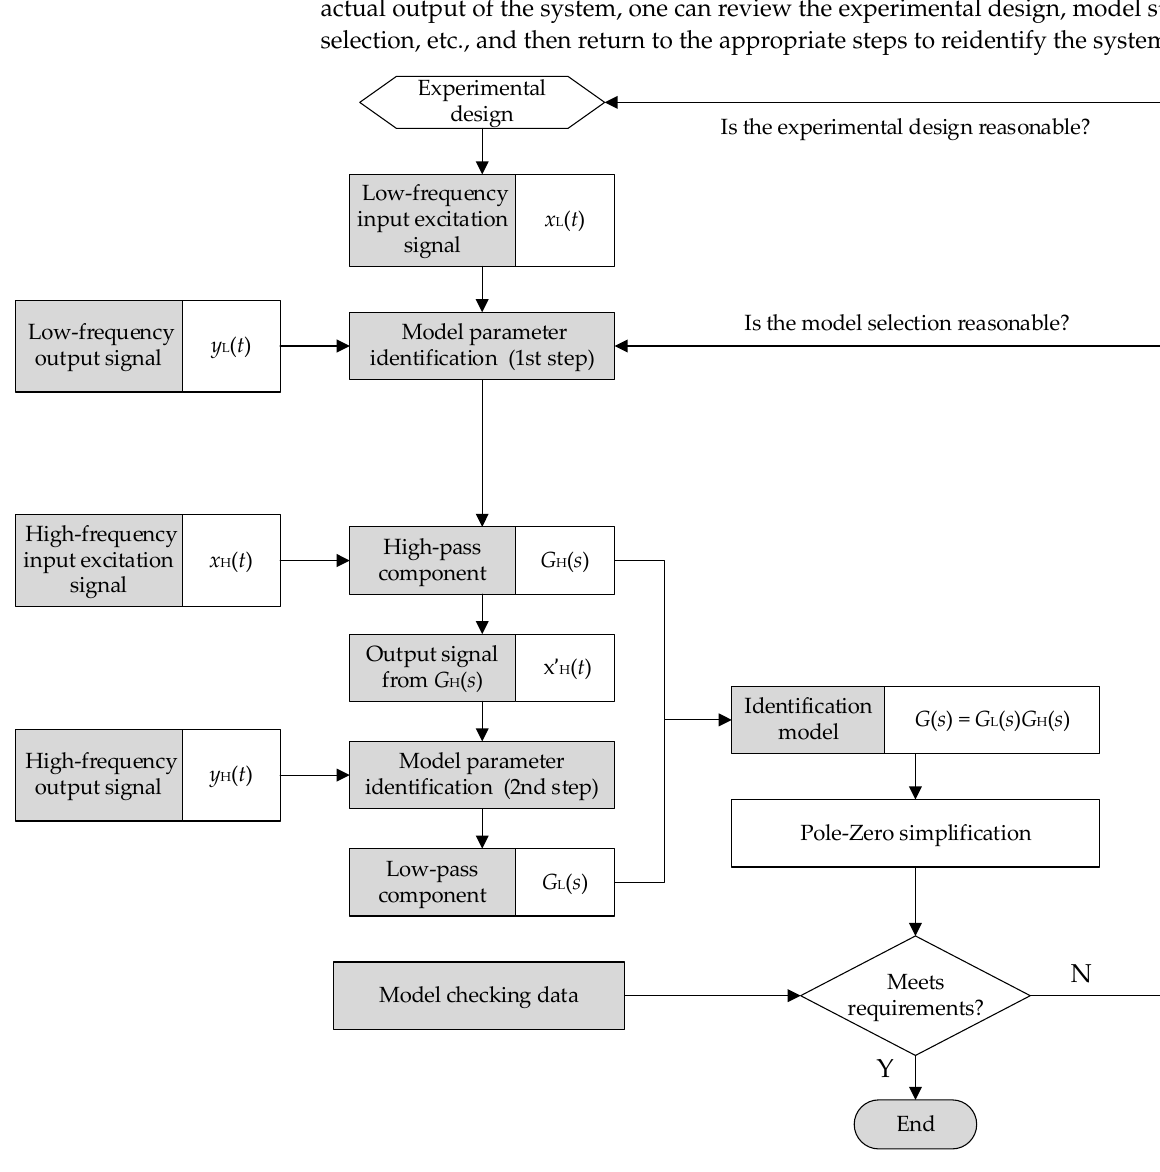
Figure 4. F lowchart of the two-step identification algorithm for broadband measurement system. Figure 4. Flowchart of the two-step identification algorithm for broadband measurement